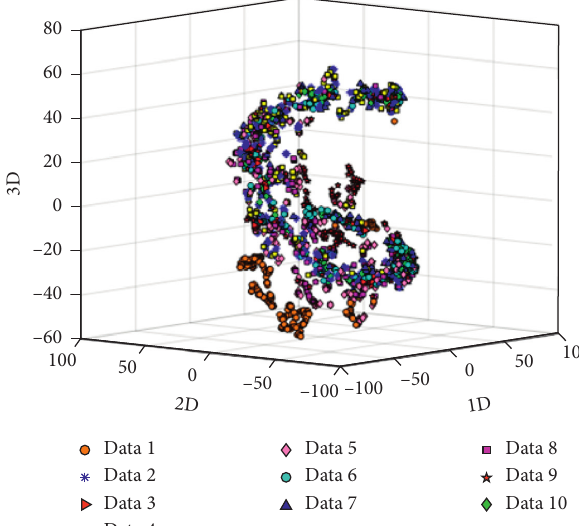
Figure 5: 3D feature scatter diagram of the raw